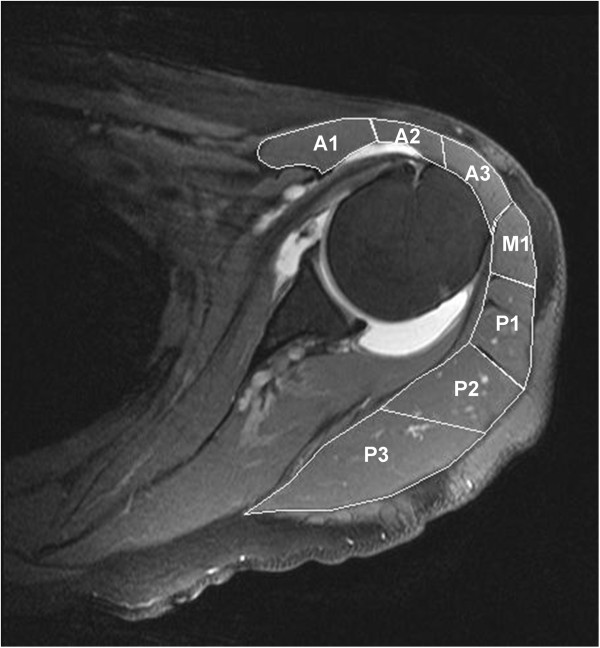
Area of anatomic deltoid muscle segments. On T2 weighted transverse MR images the area of seven anatomic defined segments of the deltoid muscle were measured exactly at the mid-glenoid level. These segments were identified following the visible tendons from their origin-points of the clavicle (A1), the anterior surface of the acromion (A2), the lateral aspect of the acromion (A3, M1 and P1) and the scapular spine (P2 and P3) respectively.